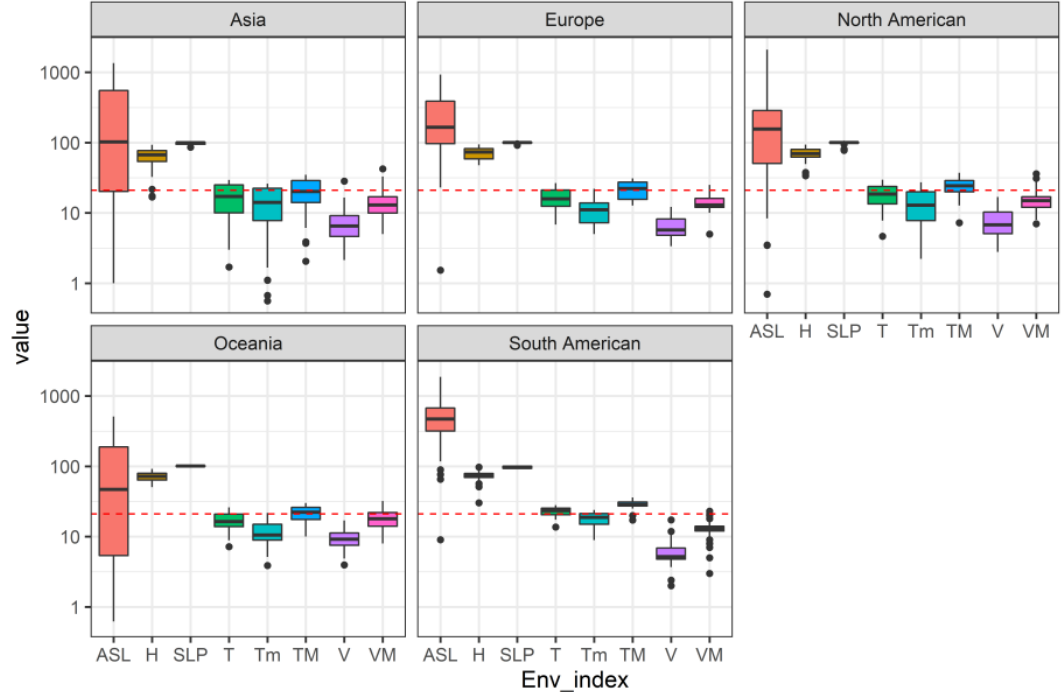
Figure 2. Boxplot of environmental factors of Batrachospermaceae plants in different continents.